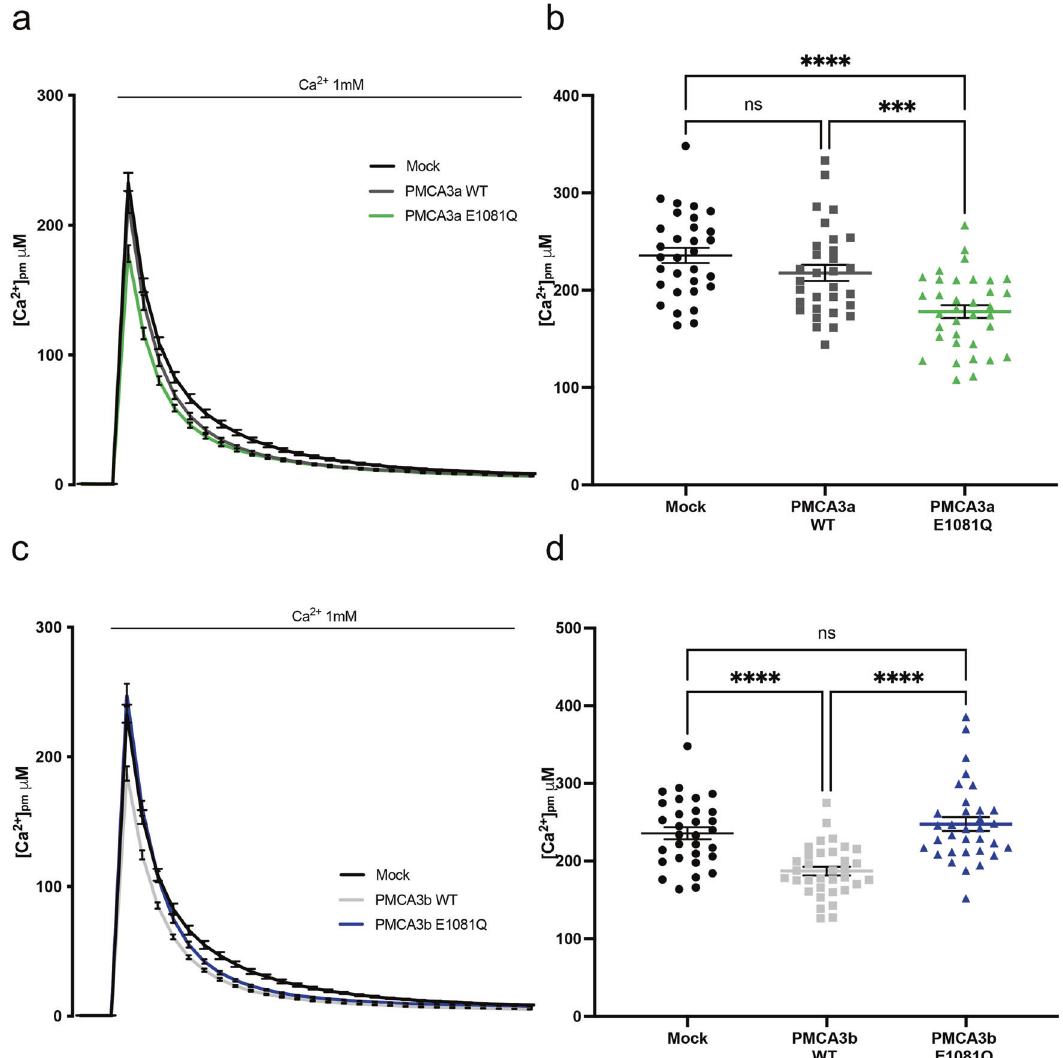
Fig. 4 Analysis of the sub-plasma membrane Ca 2 + microdomains in HeLa overexpressing wt or E1081Q PMCA3 a or3 b variants. HeLa cells were co-transfected with pmAEQ (targeted to sub-PM region) and the PMCA3 wt and E1081 mutants constructs for the two splicing variants a a , b and b c , d . Subplasmalemmal region ([Ca 2 + ] pm ) was monitored after a reconstitution with coelenterazine in Ca 2 + -free KRB and and perfused in the presence of KRB/Ca 2 + 1 mM a – c . The average peak values are shown in b – d . Bars represent means ± SEM obtained by averaging the values obtained in at least 30 independent measurements from three independent transfections for each condition. ***, p < 0.001; ****, p < 0.0001: ns not signi fi